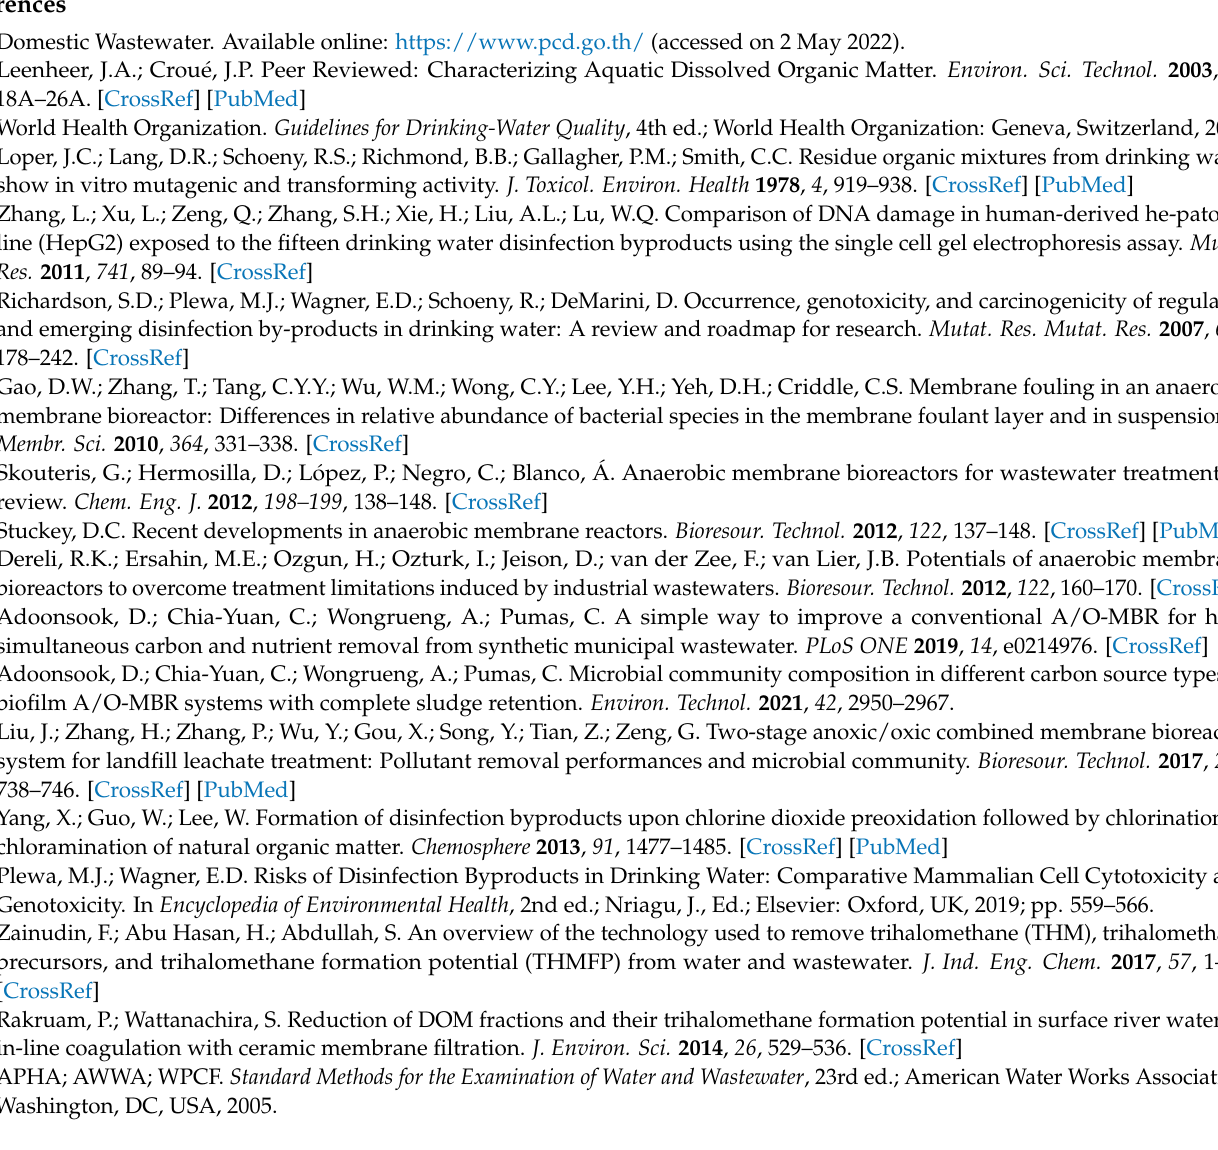
) removal, and Table S7. 2 ) 3